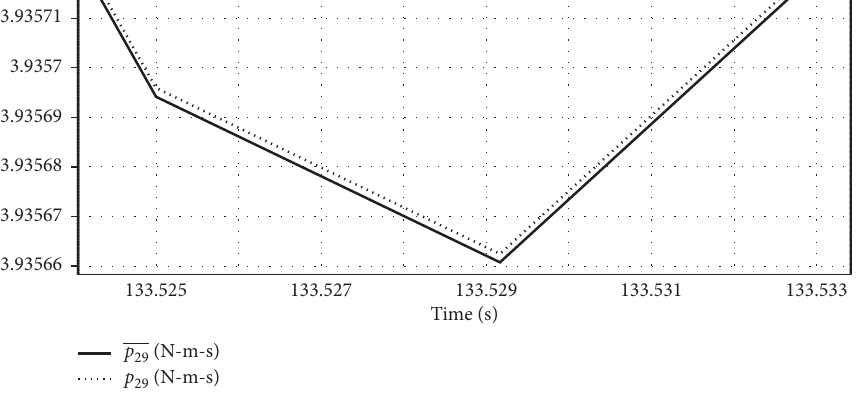
Figure 19: Close up of Figure 18.